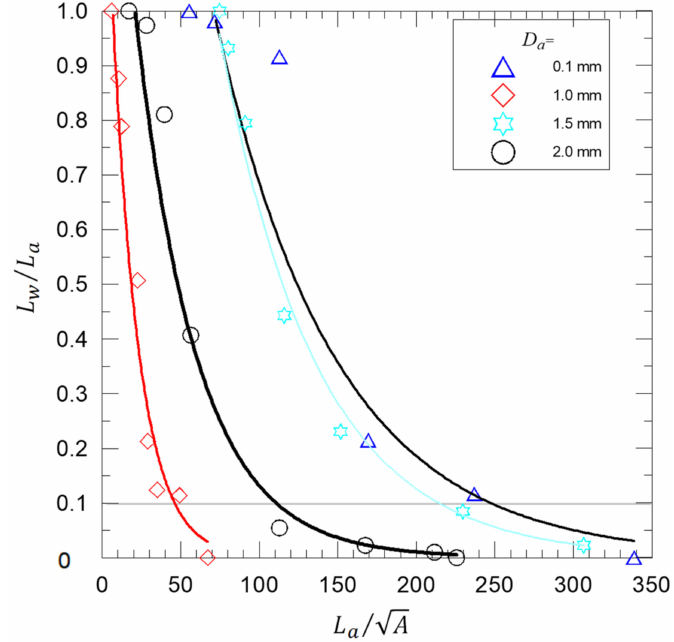
√ A of strips made of different materials and sizes.